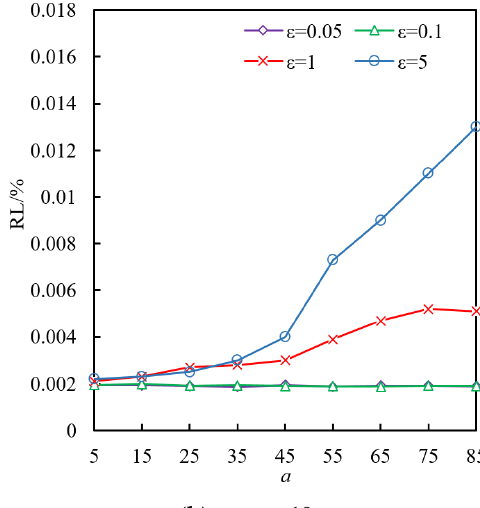
Figure 5. Change trend of SSE for the Adult dataset.